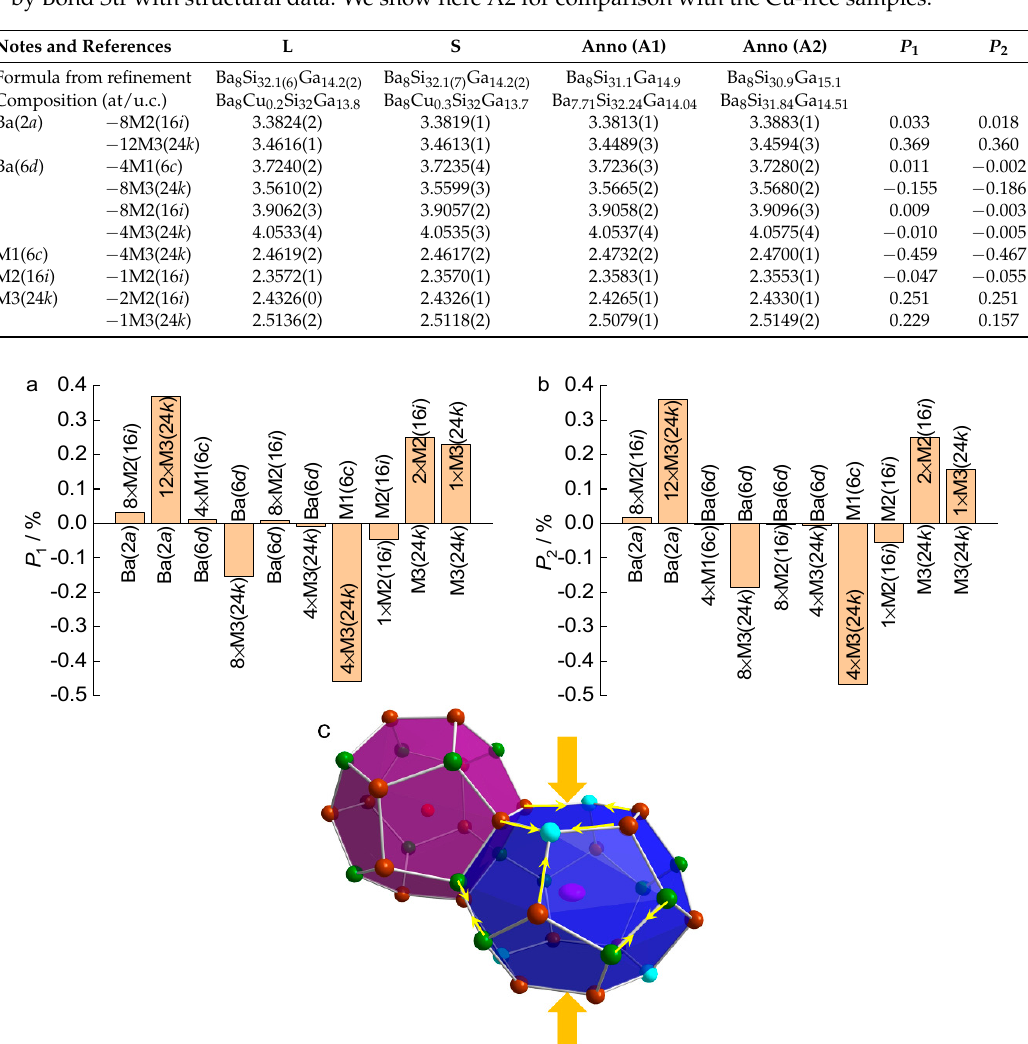
Table 2. Selected refined interatomic distances (Å) for L and S and for the samples from Ref. [46] (A1 and A2). For comparison, we calculated the change percentages ( P i (%)) based on the Cu-free sample